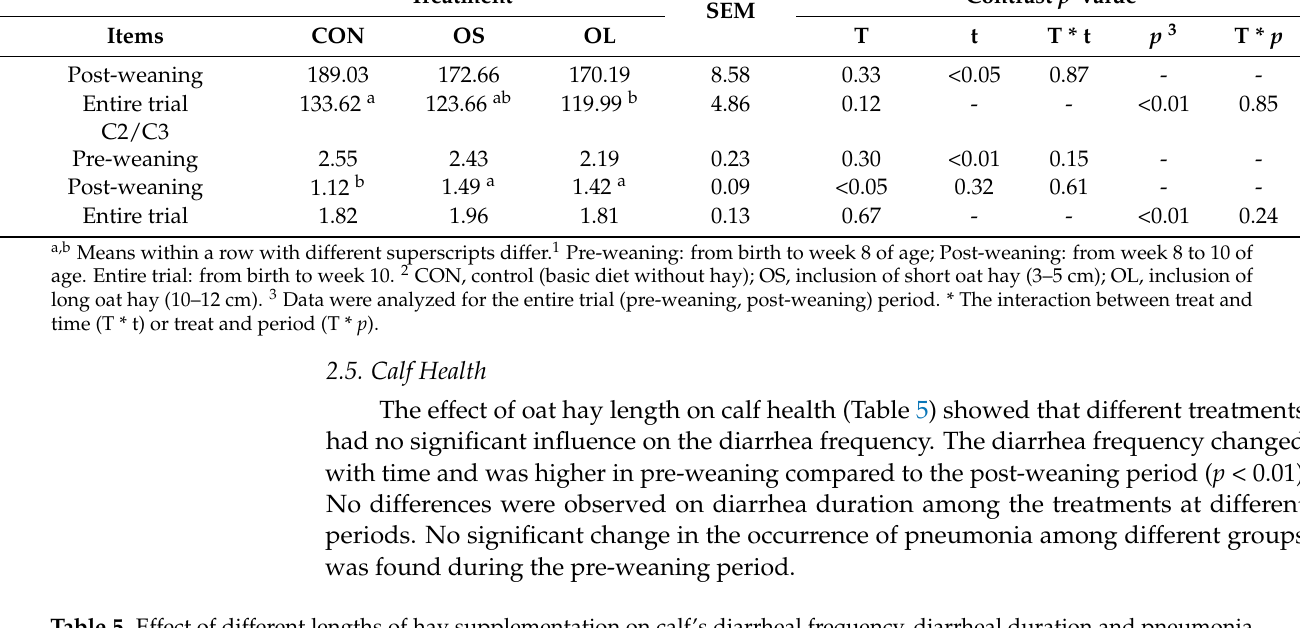
Table 5. Effect of different lengths of hay supplementation on calf’s diarrheal frequency, diarrheal duration and pneumonia occurrence during different periods 1